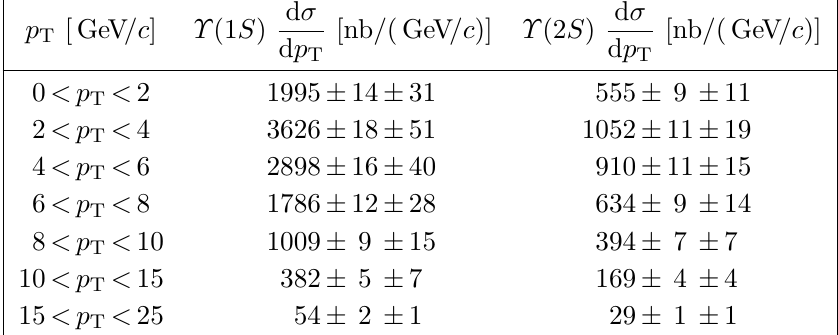
Table 10 . Scaled pp di(cid:11)erential cross-section in p T at statistical, the second is systematic, which includes the systematic uncertainty from the pp mea- surement and that estimated by changing the interpolation function.